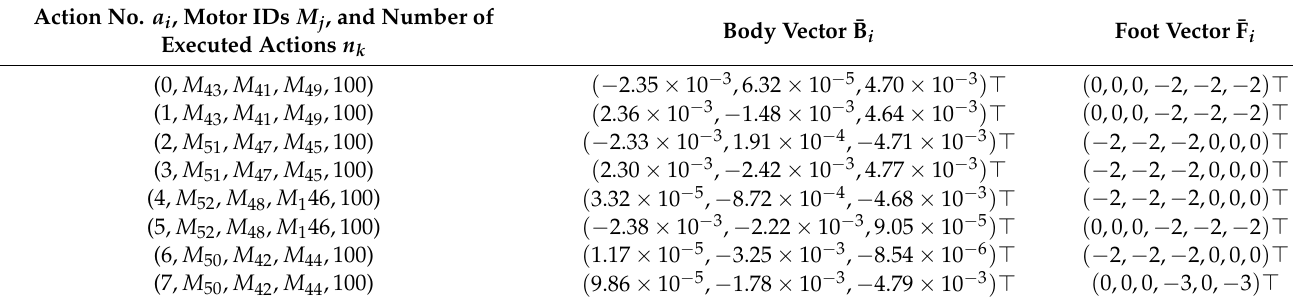
Table 4. Results of body calibration in Robot 2. This robot has motor IDs M 41 to M 52 . Action No. a i , Motor IDs M j , and Number of